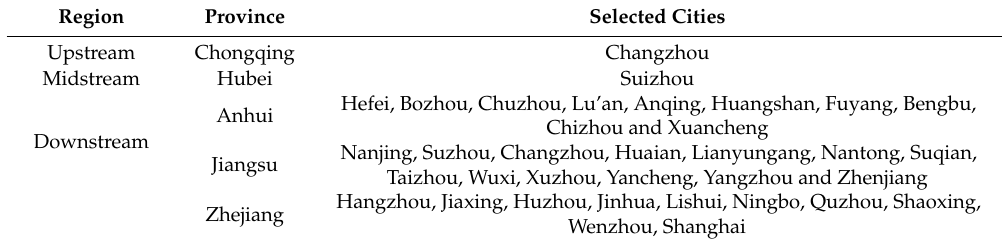
Table 1. Cities in the Yangtze River Economic Delta